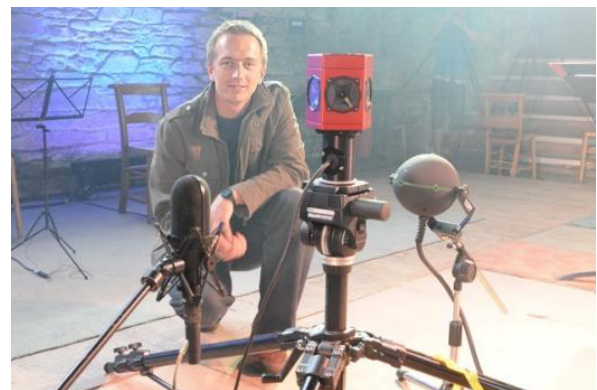
Figure 15 Ladybug 3 - spherical video camera in action.